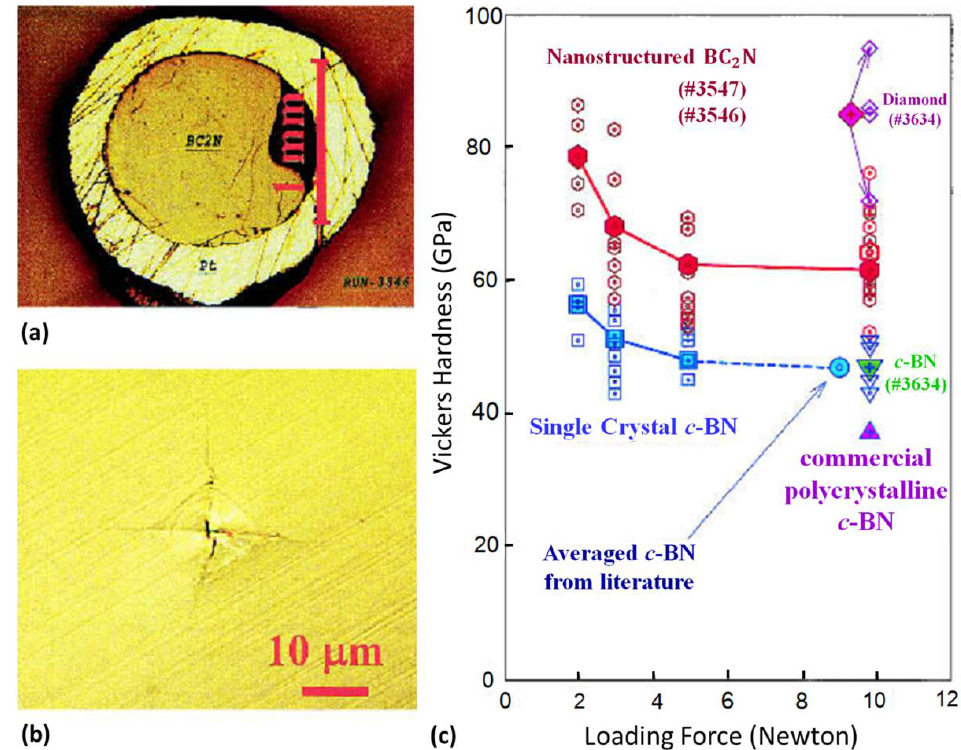
Figure 3. ( a ) Optical micrograph of the BC 2 N sample synthesized under high P–T conditions. The outer yellowish ring is the platinum capsule. ( b ) Vickers indentation produced by a diamond indenter at a loading force of 9.8 N. ( c ) Vickers hardness data. Empty symbols show individual measurements, whereas filled symbols are averaged data. For comparison, the figure also shows hardness measurements for cBN single crystals, polycrystalline diamond, and cBN composite (run no. 3634). The circle denotes the average hardness of cBN at a loading force of 9.8 N taken from the literature. The empty inverted triangles show the measurement on cBN from the diamond + cBN composite, and the filled inverted triangle shows the average of the measurements. These measured data agree exactly with the highest hardness to date on the well-sintered polycrystalline cBN sample. The upright triangle denotes the hardness of currently available commercial polycrystalline cBN (Valenite Polycrystalline Products). The empty diamond symbols show the measurement on diamond from the synthesized diamond + cBN composite, and the filled diamond symbol shows the average of the measurements. Reprinted with permission from Zhao et al., J. Mater. Res. 17 , 3139-3145 (2002). Copyright 2002 Materials Research Society (Ref. 14).